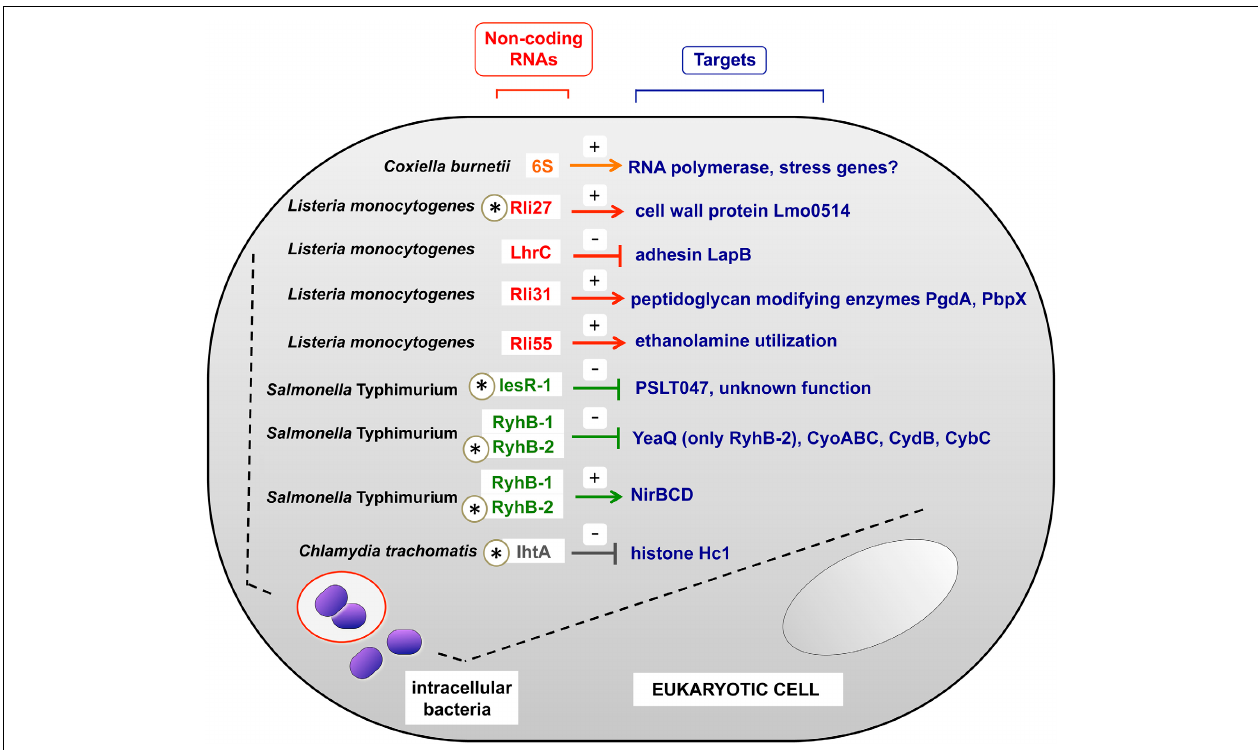
FIGURE 2 | Examples of sRNAs produced by intracellular bacterial pathogens inside the host eukaryotic cell. All sRNAs shown here were validated experimentally in bacteria isolated from eukaryotic cells. Note the existence of negative and positive regulation, indicated with ( − ) and ( + ) signs respectively. In those sRNAs indicated with an asterisk, the regulation over the indicated target